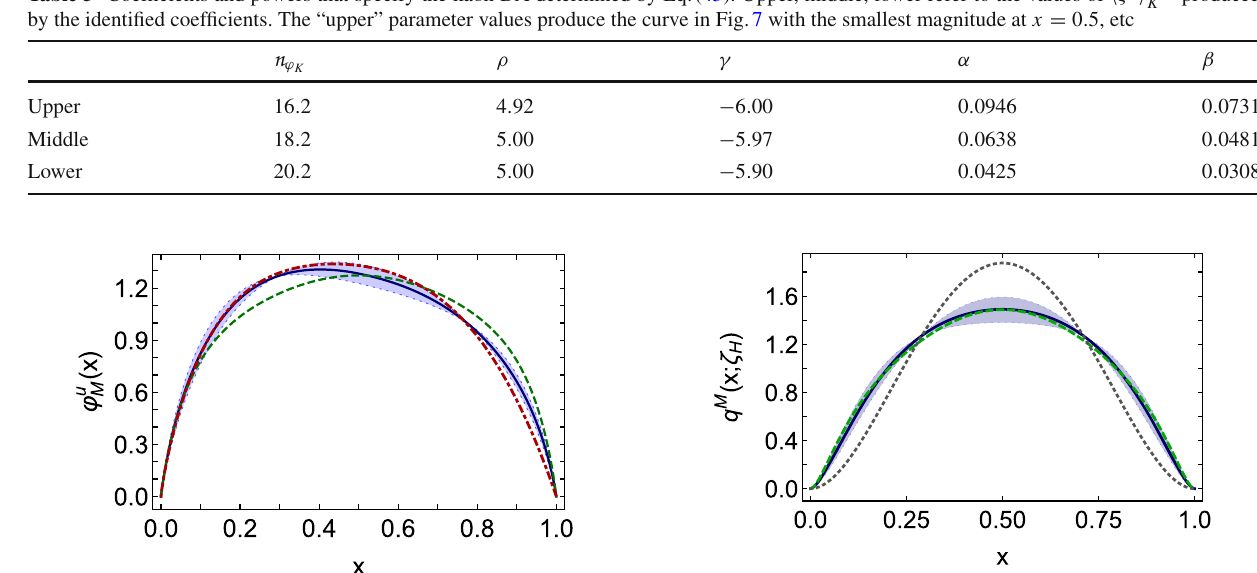
u ζ H produced K